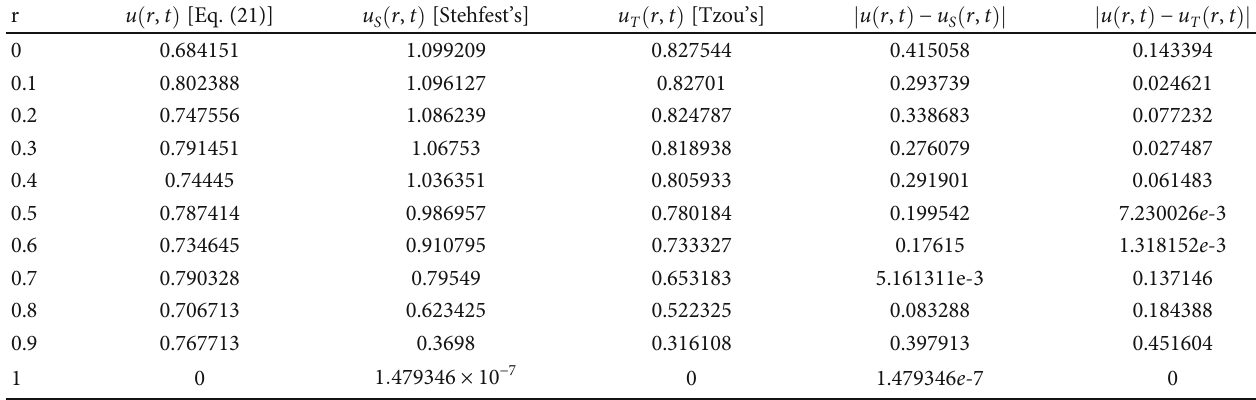
Table 1: Comparison of two Laplace inverse numerical algorithms with analytical